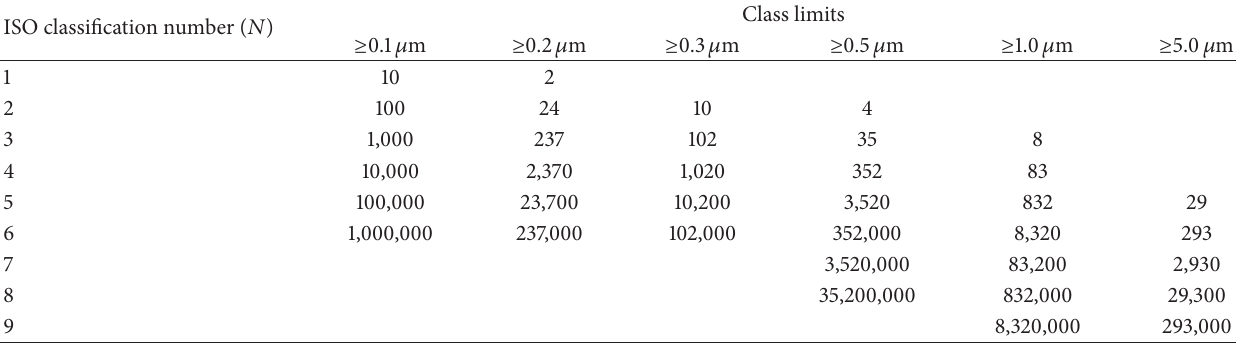
Table 2: ISO-14664, cleanrooms, and associated controlled environments (particles/m 3